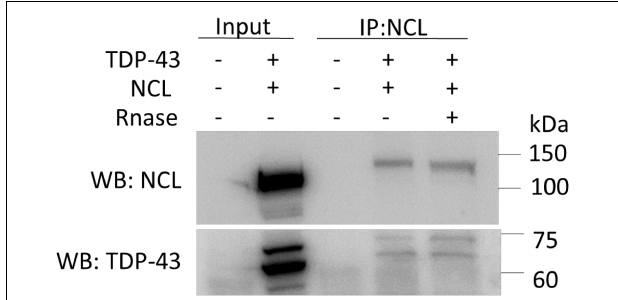
FIGURE 10 | TDP-43-mKate2 and NCL-GFP co-immunoprecipitate in HEK293T cells independently from the presence of RNA. Proteins extracted from cells co-transfected with TDP-43-mKate2 and NCL-GFP expression vectors (+/+), or from non-transfected cells (–/–), were treated (+) or not (–) with RNase A and immunoprecipitated using the anti-NCL antibody. The immunocomplexes were analyzed by WB using either anti-GFP (upper panel) or anti-TDP-43 (lower panel) antibodies, showing the presence of both NCL-GFP (band between 100 and 150 kDa) and TDP-43-mKate2 (bands between 60 and 75 kDa) irrespective of RNase treatment. 20 µ g of the total cell lysates (Input) were loaded as control. Shown results are representative of three different